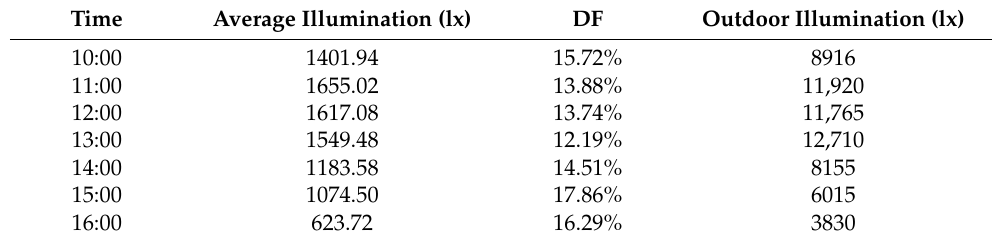
Table 2. Atrium illumination measurement results.